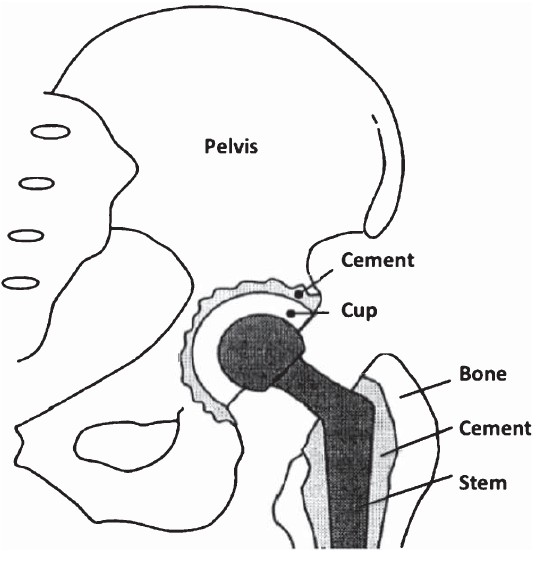
Fig. 1. A Schematic of the total hip